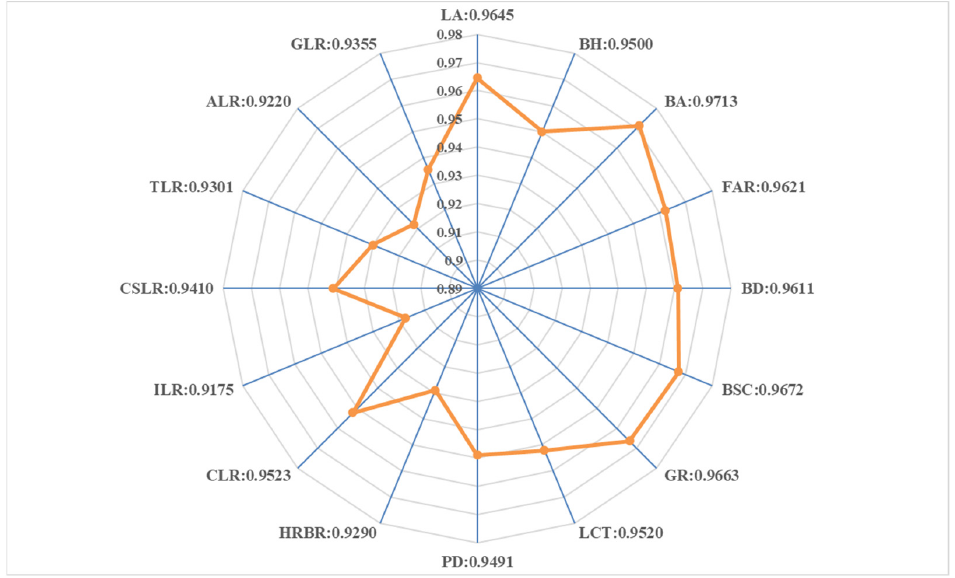
Figure 5. Grey correlation coefficient between BEF and RLCE.